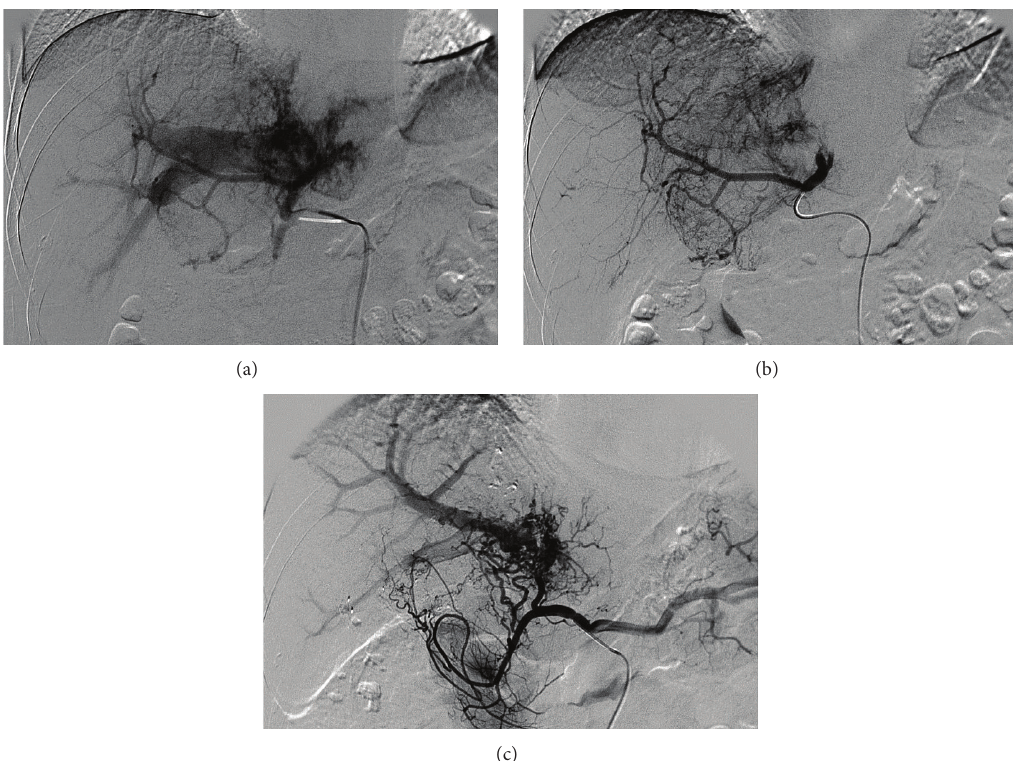
Figure 2: Hepatic arteriography images. Figures 1(a), 1(b), and 1(c) refer to 5, 5, and 151 days after the diagnosis of the tumor, respectively. Figure 1(a) shows early visualization of the right branch of portal vein which implies a prominent APS. Figure 1(b) demonstrates the tumor staining and the occlusion of the APS due to the embolization with gelfoam through the left hepatic artery. Figure 1(c) reveals reestablishment of the APS and tumor shrink after the treatment by TACE and TAC plus